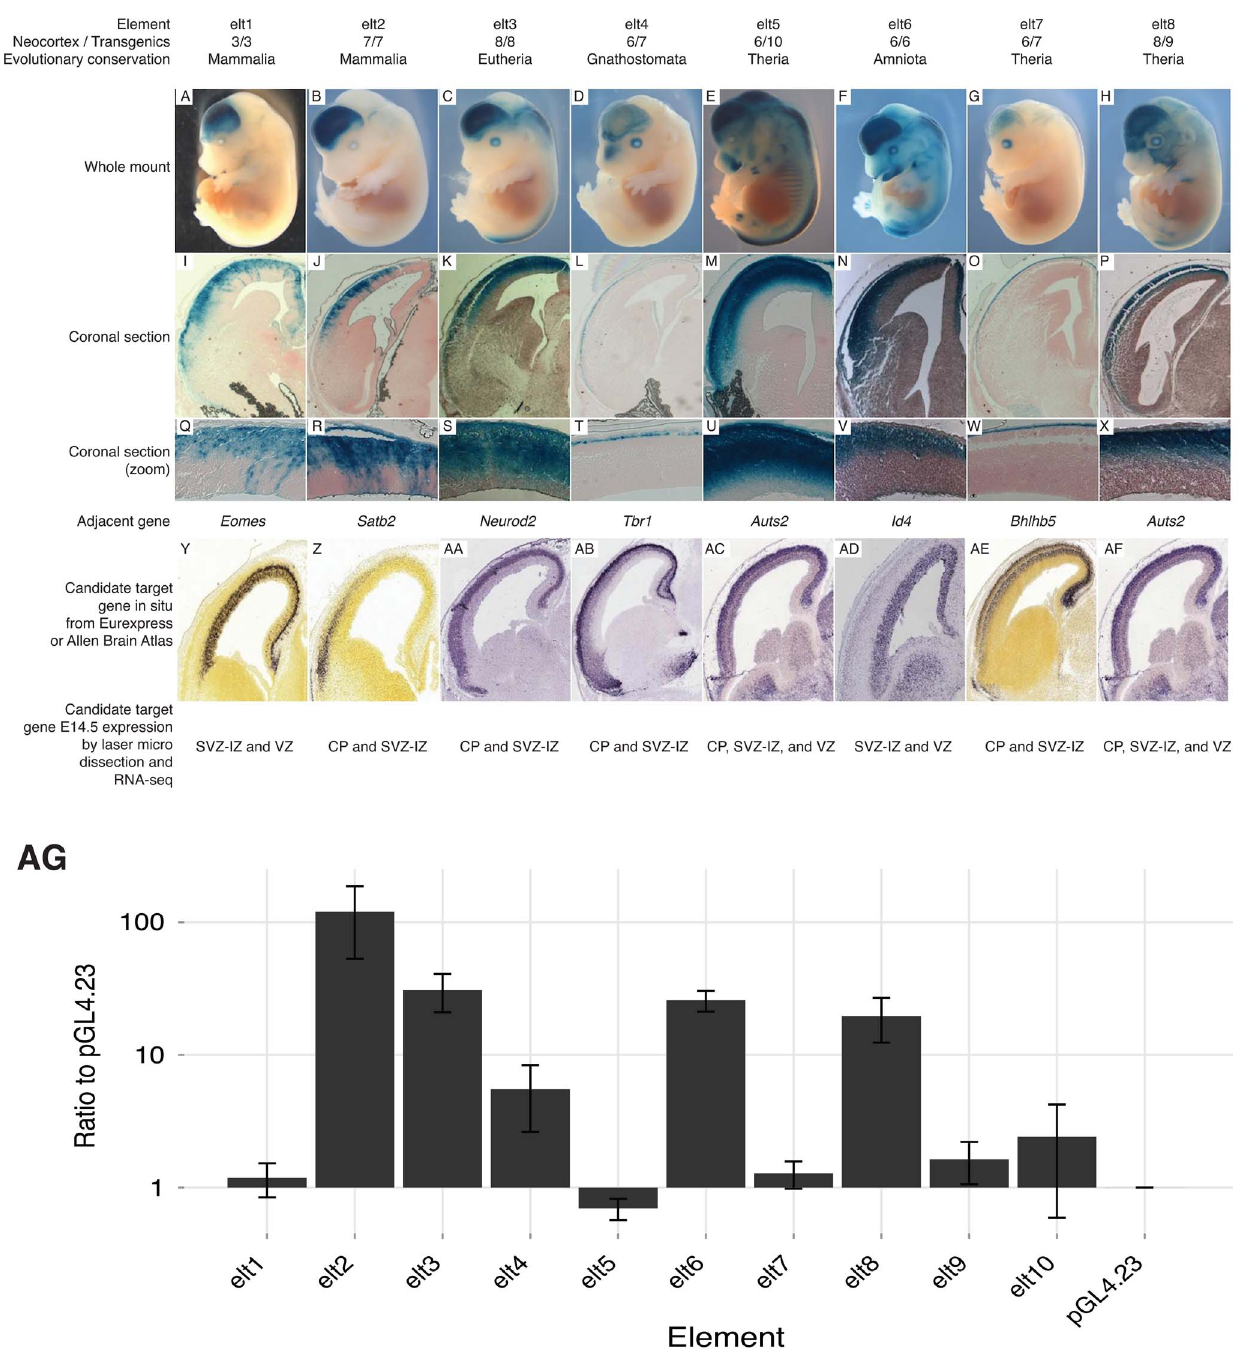
Figure 2. Candidate enhancers drive laminar expression in the developing mouse neocortex. Of the 10 assayed candidates, 8 (80%) drive reproducible expression in the developing neocortex. A–H) Whole mounts show expression in the cerebral cortex. I–P) Coronal sections reveal dorsal- specific expression exclusive of the ganglionic eminences. Q–X) Zooms of coronal sections reveal distinct laminar patterns. Y–AF) In situs of key neocortical genes found next to tested elements at E14.5 (coronal: Y–Z, sagittal: AA–AF). Y,Z,AE from Allen Brain Atlas; AA–AD,AF from Eurexpress. Below each gene in situ is the gene expression pattern from [14]. AG) Transfection results of our 10 elements in a higher throughput dissociated neuron transfection system. Five (63%) of eight transient transgenic positive enhancers drive high expression levels compared to the empty vector, and two transgenic negatives. seq peaks [9] are conserved outside of mammals, and over 35% of E11.5 it consists of mostly progenitor cells [7]. The deeper conservation of E11.5 forebrain enhancers is consistent with the forebrain p300 ChIP-seq peaks from E11.5 embryos [10] are conserved outside of mammals (Figure 5B). The forebrain hypothesis that the early forebrain is more homologous across encompasses both the telencephalon and diencephalon, and at vertebrates [1].